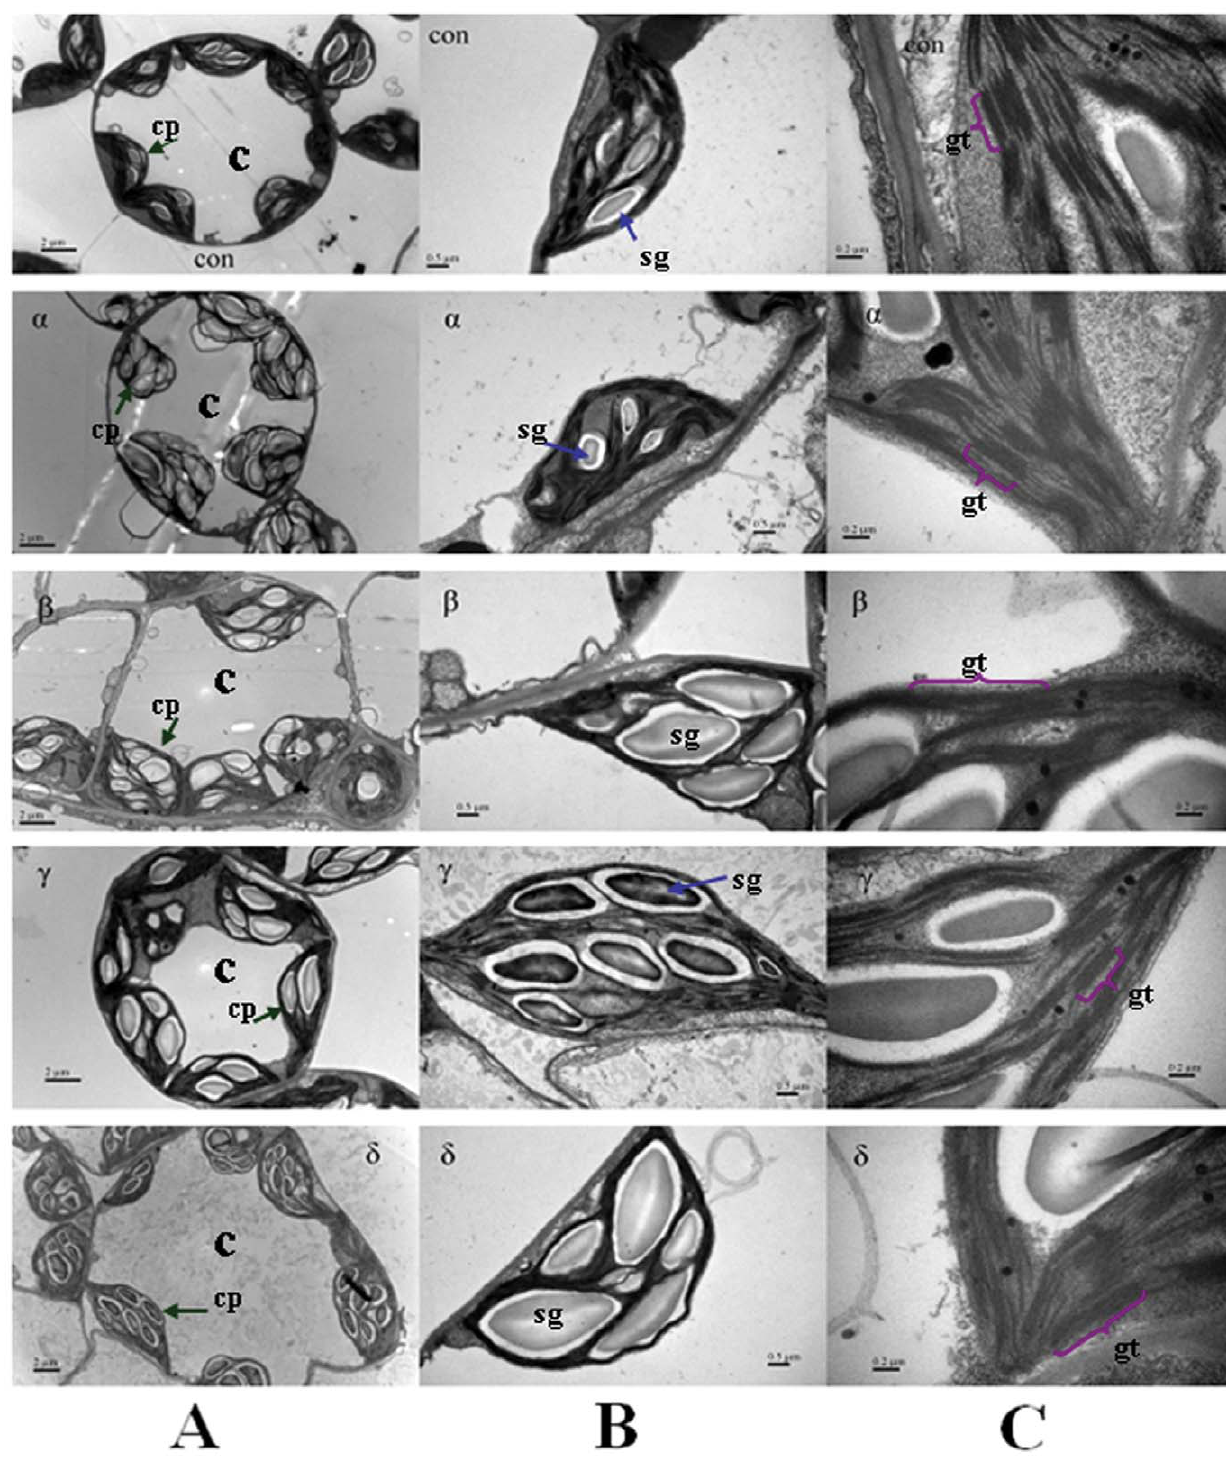
Figure 2. The substructure of Arabidopsisthaliana leaves treated by a -, b -, c - and d -HCH. (A) Mesophyll cell structure; (B) Chloroplast; and (C) Thylakoid structure. The Chloroplast (cp), starch granules (sg) and granal thylakoid (gt) are marked with colorful arrows respectively. species was disparate. In our experiment, photosynthetic system and antioxidant defense system were first chosen to investigate the plant responses to HCH isomers. Photosynthesis is the basic course of organic chemicals synthesis by which plants and algae using sun